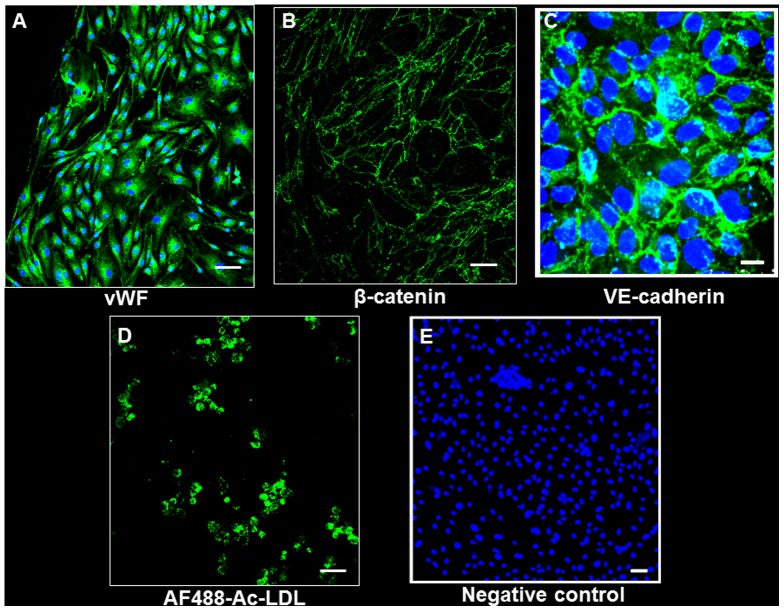
Staining to confirm endothelial identity of pregnant sheep uterine artery endothelial cells (UAECs).Endothelial identity was confirmed by (A) anti-vWF staining; (B and C) cobble-stone shaped appearance following staining with anti-β-catenin and anti-VE-cadherin respectively; (D) uptake of fluorescently labeled Ac-LDL. (E) is a representative negative control wherein the addition of the primary antibody was omitted. Scale bar = 100 µm (A, D and E); 50 µm (B and C).